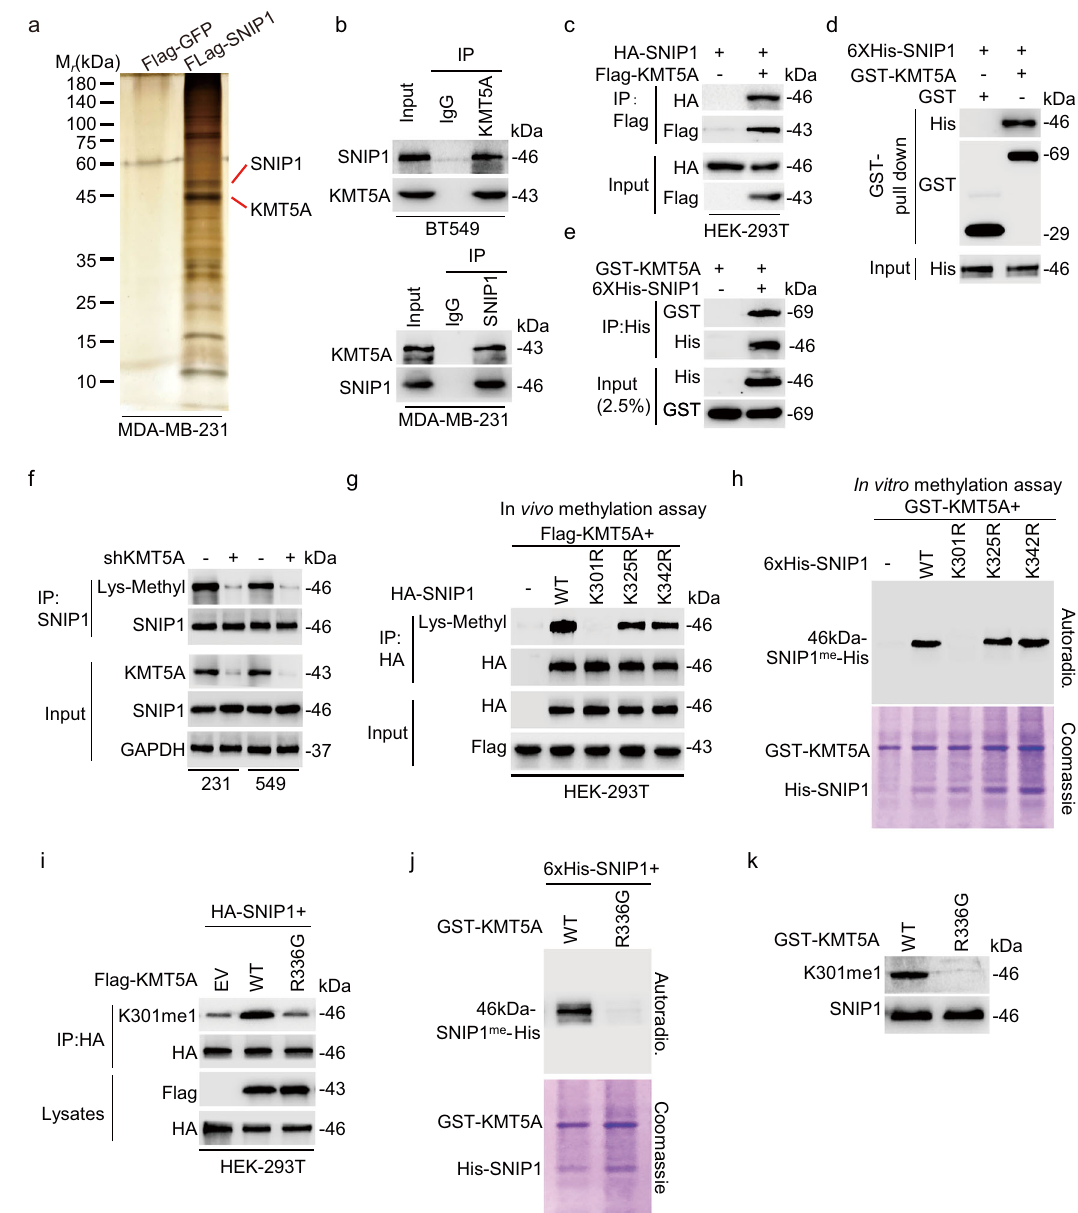
Fig. 2 SNIP1 interacted with and was methylated at Lys301 by KMT5A. a Immunoprecipitation followed by silver staining of the SNIP1 binding proteins. b Co-immunoprecipitation of endogenous SNIP1 with anti KMT5A antibody in BT549 (upper) and endogenous KMT5A with anti SNIP1 antibody (lower) in MDA-MB-231 cells ( n = 3). c Immunoprecipitation and western blotting for Flag-KMT5A association with HA-SNIP1 protein in HEK-293T cells ( n = 3). d , e GST pulldown with puri fi ed GST-KMT5A ( d ) and Ni-NTA pulldown with 6X His-SNIP1 ( e ) followed by immunoblotting with anti-His and GST antibodies ( n = 3). f Immunoblot analysis of the lysine methylation of SNIP1 in control and KMT5A-knockdown MDA-MB-231 and BT549 cells. Lysates were assessed by immunoprecipitation (IP) with anti-SNIP1 and immunoblotting with anti-Lys-Methyl. g , In vivo methylation assay for the detection of SNIP1 methylation by western blotting using anti-Lys-Methyl. HA-tagged SNIP1 WT , SNIP1 K301R , SNIP1 K325R , and SNIP1 K342R mutants were immunoprecipitated with anti-HA magnetic beads from HEK-293T cells co-expressed with Flag-KMT5A ( n = 3). h Autoradiography of the in vitro methylation assay using puri fi ed GST- KMT5A and 6× His-SNIP1. Top panel, 3H-SAM is the methyl donor, and methylation visualized by autoradiography. Bottom panel, total amounts of GST- KMT5A and 6× His-SNIP1 are shown by Coomassie brilliant blue (C.B.B.) staining. Empty vector (EV). Wild-type (WT) ( n = 3). i Effects of wild type and methyltransferase activity-de fi cient mutant R336G of KMT5A on SNIP1-K301 methylation ( n = 3). j Autoradiography of the in vitro methylation assay using puri fi ed GST-KMT5A WT or methyltransferase activity-de fi cient mutant GST-KMT5A R336G and 6× His-SNIP1. Top panel, 3H-SAM is the methyl donor and methylation visualized by autoradiography. Bottom panel, total amounts of GST-KMT5A WT or -KMT5A R336G and 6× His-SNIP1 are shown by Coomassie brilliant blue (C.B.B.) staining. Wild-type (WT) ( n = 3). k In vitro methylation assay was performed with wild-type and mutant KMT5A on recombinant SNIP1 and probed with anti-K301me1 ( n = 3). Data information: Panels ( b – k ) show 1 experiment representative of three independent experiments with similar